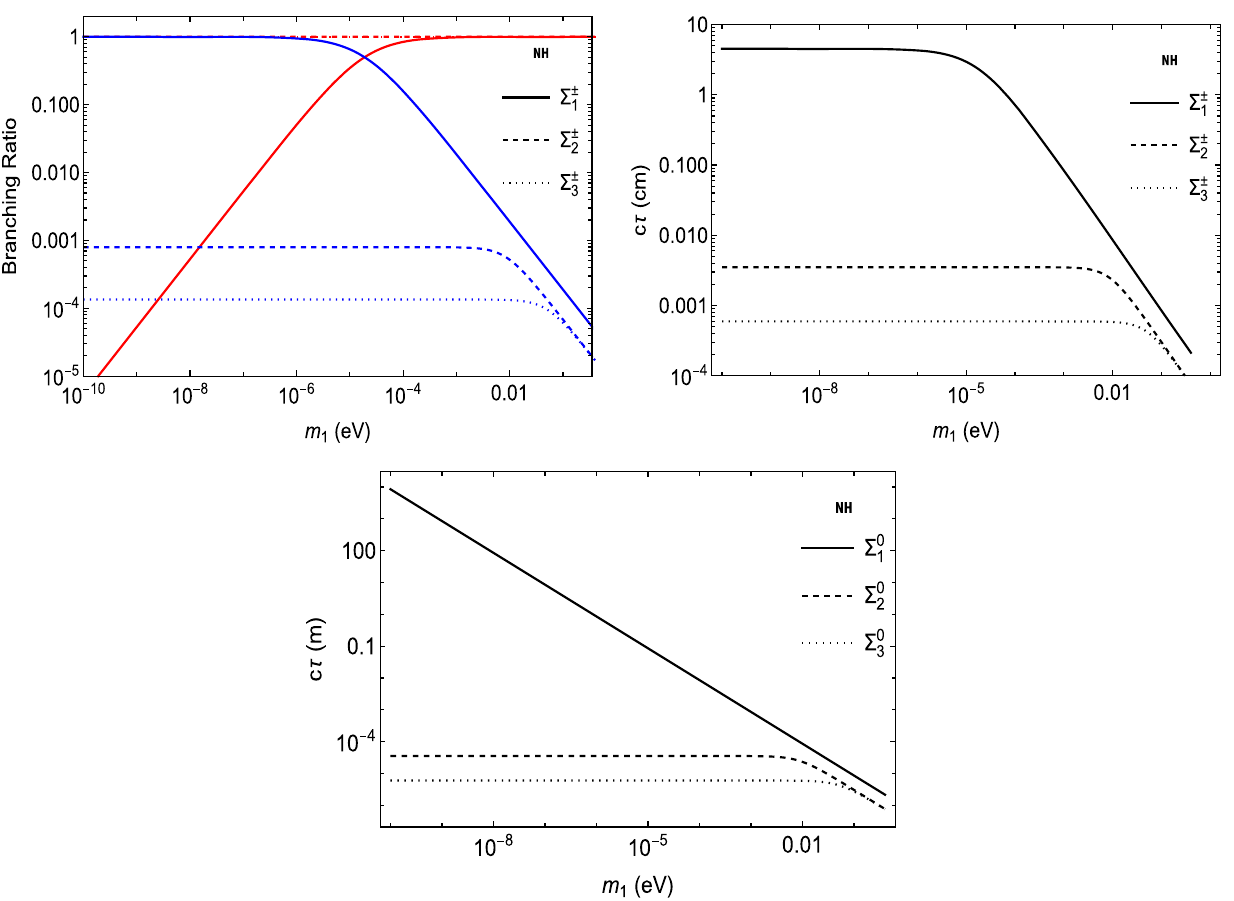
= 600 GeV, and m (cid:2) 1